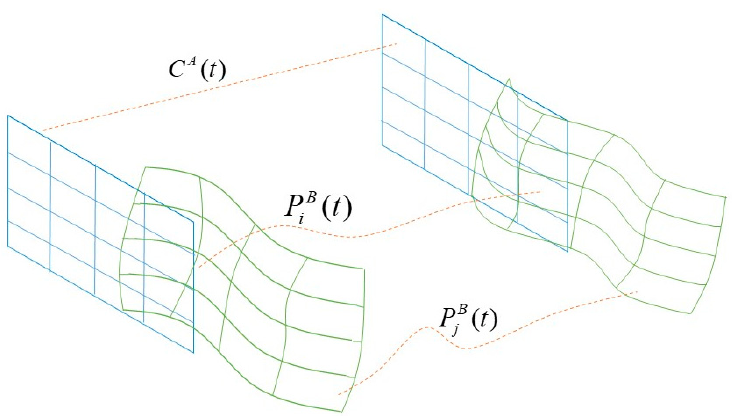
Figure 4. The process of unified stitching and stabilization. Table 1. The flight parameters of two UAVs.